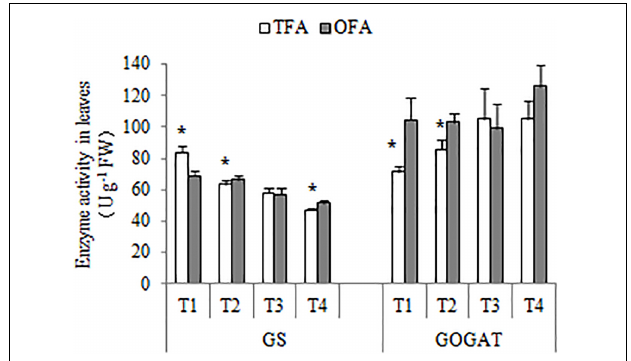
FIGURE 8 | GS and GOGAT activities under various nitrogen source treatments (2016). TFA: traditional nitrogen fertilizer application; OFA: optimized nitrogen fertilizer application; T1: jointing stage; T2: 15–20 days after jointing; T3: heading stage; T4: 15 days after heading; FW: fresh weight. Data represent mean values of three biological replicates ± SE. “ ∗ ” indicates significant differences between treatments at the 0.05 probability level.